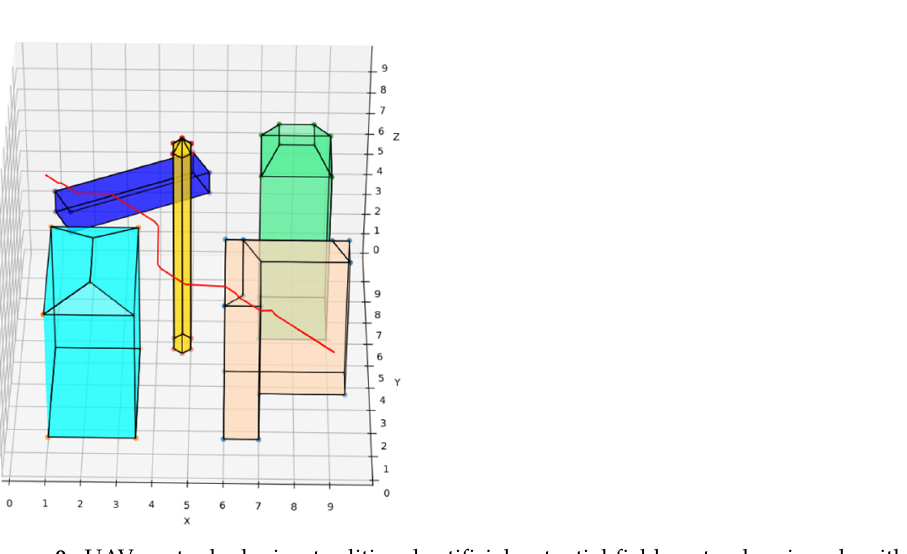
Figure 10. UAV route deploying REPARE algorithm in disturbance-free scenarios. The starting and target points are randomly generated, and after a large number of repeated experiments, the average running time and distance of the three algorithms are compared, and they are normalized by the parameters of the traditional artificial potential field route planning algorithm. The comparison results are shown in Table 2. Table 2. Comparison of the three algorithms’ average time and distance Algorithm